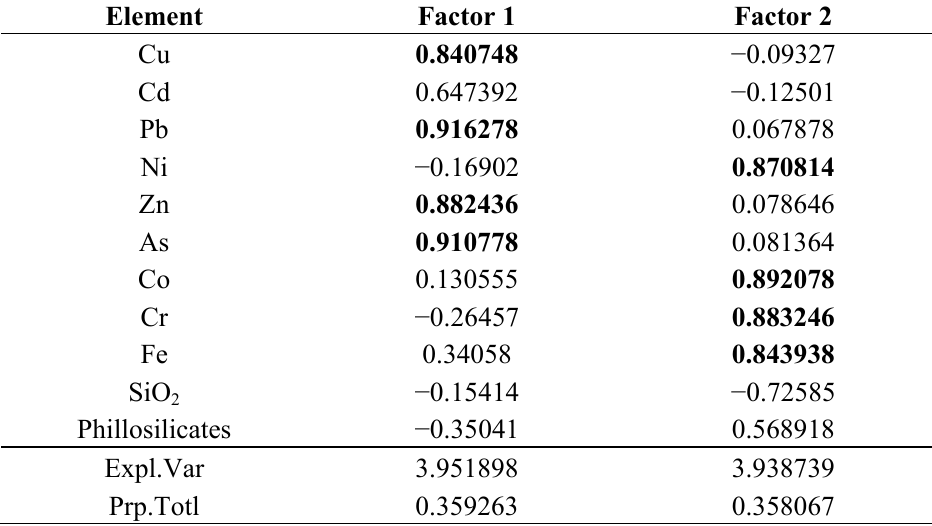
Table 8. Eigenvectors F1 and F2 after varimax